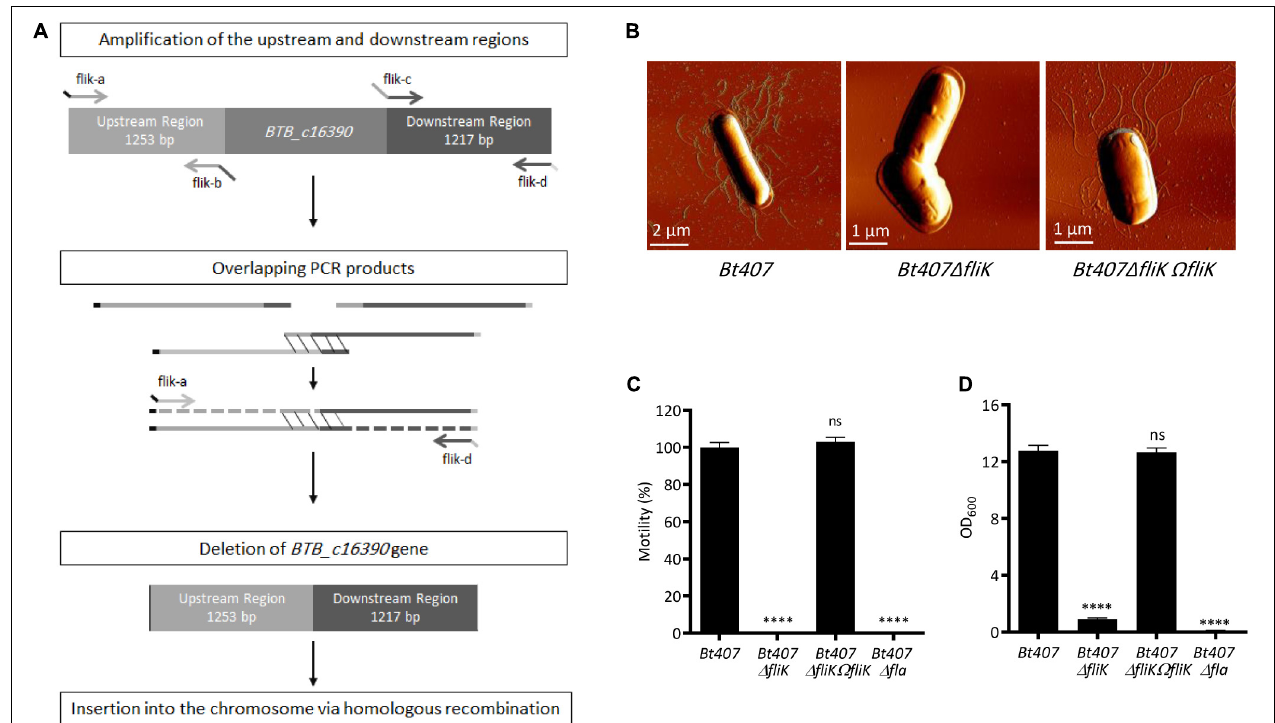
FIGURE 2 | FliK is required for Bt407 flagellar assembly. (A) Schematic diagram showing the construction of an in-frame deletion of the BTB_c16930 gene by Splicing by Overlap Extension (SOE). (B) Scanning Atomic Force Microscopy (AFM) of exponential growth phase cells of Bt407 , Bt407 (cid:49) fliK, and Bt407 (cid:49) fliK (cid:127) fliK . (C) Bacterial motility on LB soft agar (0.25%) medium. Motility of the Bt407 strain was set to 100%, and values obtained with other strains were set as fold relative to this value. (D) Total biofilm biomass at the air-liquid interface in glass tubes, following 48 h incubation at 30 ◦ C. Data obtained from three independent experiments are combined in single value (mean ± SD). Statistical tests were performed using the Mann-Whitney test within Prism software (ns: p > 0.05; ∗∗∗∗ p < 0.0001).